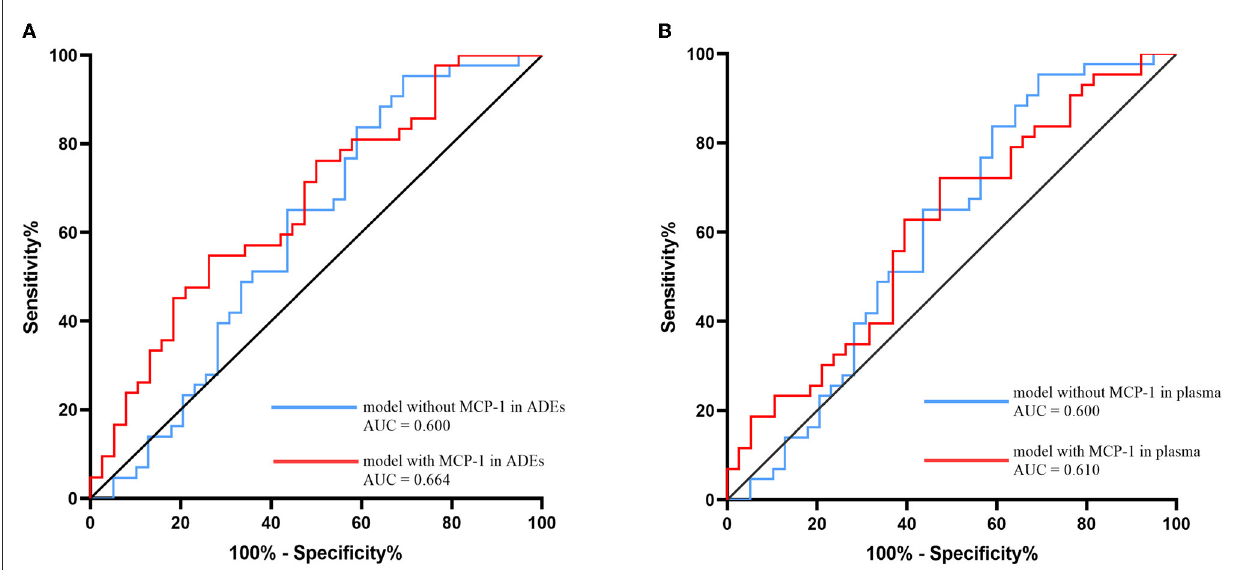
FIGURE3 Receiver operating characteristic (ROC) evaluated the MCP-1 in ADEs (A) or MCP-1 in plasma (B) ability to distinguish the SCD and NC group. Models with sex, age, APOE genotype, and years of education included as covariates with MCP-1 in ADEs/plasma are shown with red lines and without